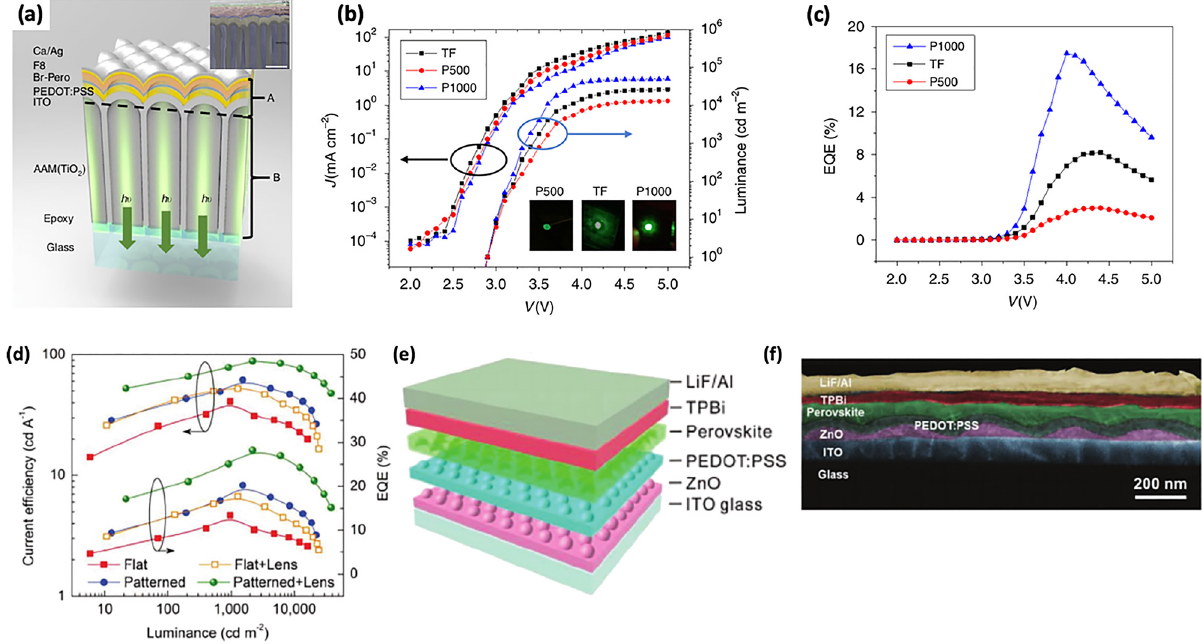
Figure 6: Devices on nanophotonic substrate (a) Device schematic. The materials from top to bottom are: Ca/Ag electrode, F8, CH 3 NH 3 PbBr 3 (Br-Pero), PEDOT: PSS, ITO and anodic alumina membrane (AAM). AAM channels are fi lled with TiO 2 . Device performance. (b) J – V curve, luminance and (c) external quantum ef fi ciency (EQE) of the thin fi lm (TF) and AAM samples. Reproduced with permission from [200]. (d) EQE andCEvs.luminancefordevicewith andwithoutpatterningforcomparison.(e)Schematicofdevicewithpatternedsubstrateof con fi guration glass/ITO/ZnO/PEDOT:PSS/CsPbBr 3 /TPBi/LiF/Al and (f) cross-sectional SEM. Reproduced with permission from